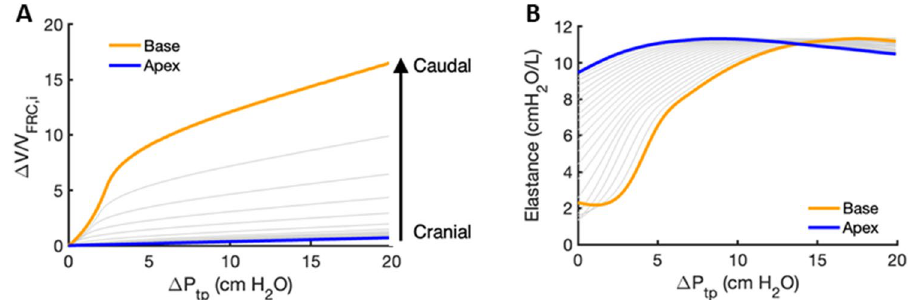
Figure 4. ( A ) Regional P–V curves with the volume change (cid:31) V normalized by the regions own volume at FRC ( V FRC , i ). ( B ) Regional lung elastance as a function of (cid:31) P tp . Elastance is defined as the inverse of the slope of the P–V curves in panel ( A ). Base and apex are shown in orange and blue, respectively, while intermediate regions are indicated by the gray lines.